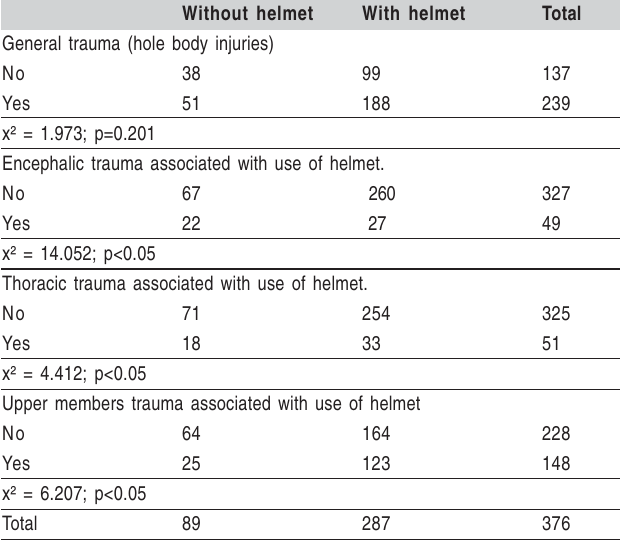
Table 3. Distribution of treatment according to the use of helmet.